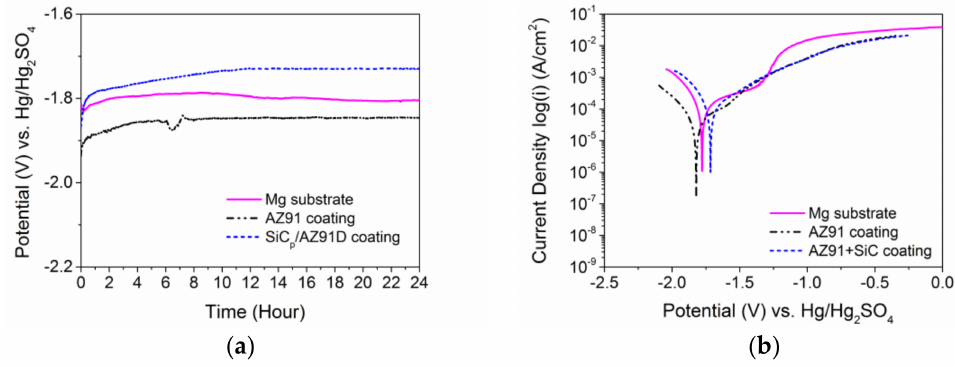
Figure 9. Corrosion characters for cold-sprayed AZ91D coating and SiC/AZ91D composite coating: open circuit potentials ( a ), and potentiodynamic polarization curves ( b